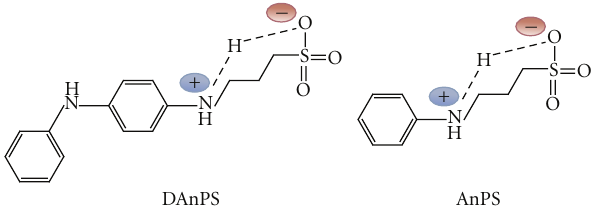
Figure 3: The zwitterionic form of the AnPS and DAnPS monomers in aqueous